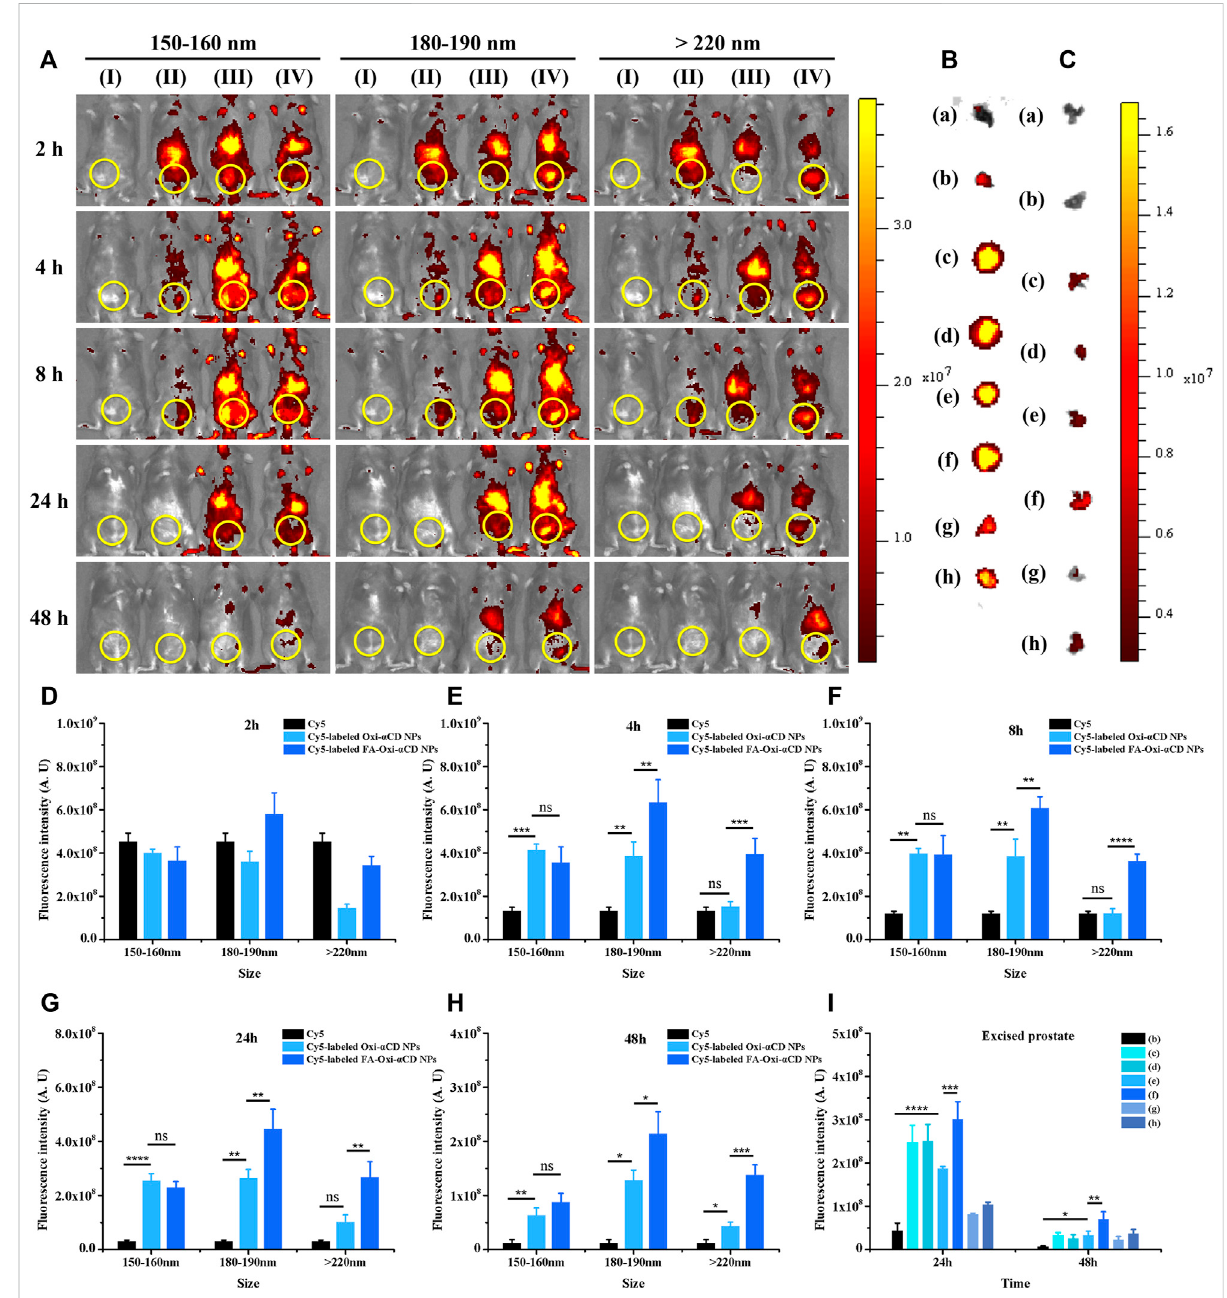
FIGURE 3 Invivo distributionofCy5-labeledOxi- α CD NPsandFA-Oxi- α CDNPsinamurine modelofCBP. (A) In vivo fl uorescenceimagesof (I) saline,(II) free Cy5, (III) Cy5-labeled Oxi- α CD NPs and (IV) Cy5-labeled FA-Oxi- α CD in a murine model of CBP at different time points after intravenous injection (the region in the yellow circle indicates the lower urinary tract and part of the reproductive system). (B – C) Ex vivo fl uorescence images of theexcisedprostates at24 h (B) and 48 h (C) postinjection: (a) saline, (b)freeCy5, (c) Cy5-labeled Oxi- α CD NPs (150 – 160 nm), (d) Cy5-labeled FA-Oxi- α CD NPs (150 – 160 nm), (e) Cy5-labeled Oxi- α CD NPs (180 – 190 nm), (f) Cy5-labeled FA-Oxi- α CD NPs (180 – 190 nm), (g) Cy5-labeled Oxi- α CD NPs ( > 220 nm) and (h)Cy5-labeledFA-Oxi- α CD NPs( > 220 nm). (D – H) ROI analysisof fl uorescence intensity inthe lowerurinary tract and part of the reproductive system was performed at different time points after intravenous injection (n = 3 per group). (I) ROI analysis of the fl uorescence intensity of theexcised prostate at24hand 48 h*,signi fi cantly differentat p < 0.05;**,signi fi cantly differentat p < 0.01; ***, signi fi cantly differentat p < 0.001; ****, signi fi cantly different at p <